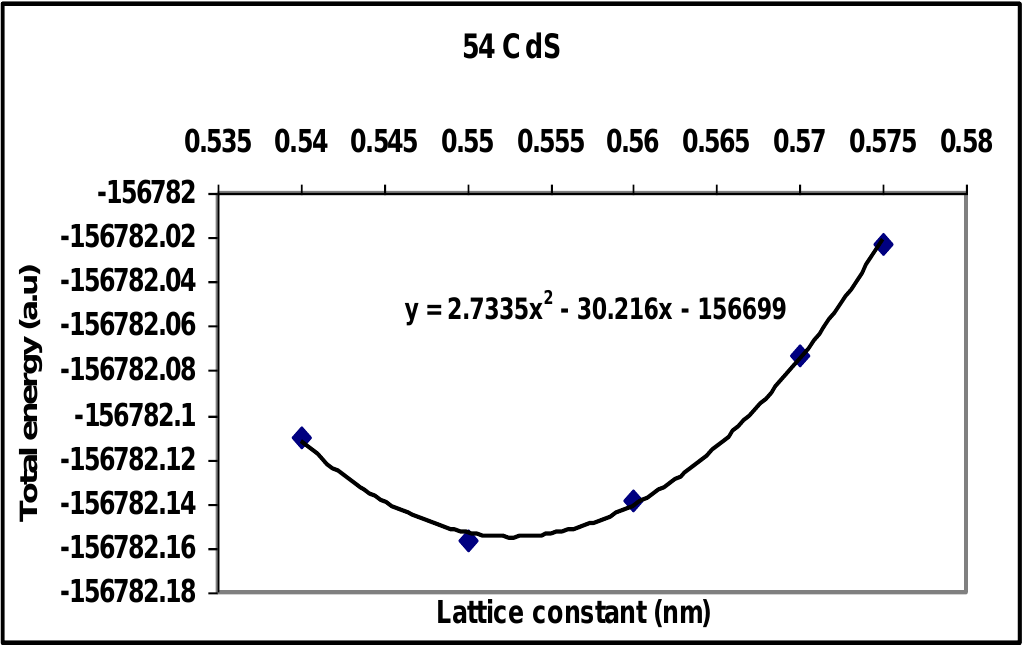
Fig.3: Total energy of 54 atoms of CdS nanocrystal core as a function of lattice constant.